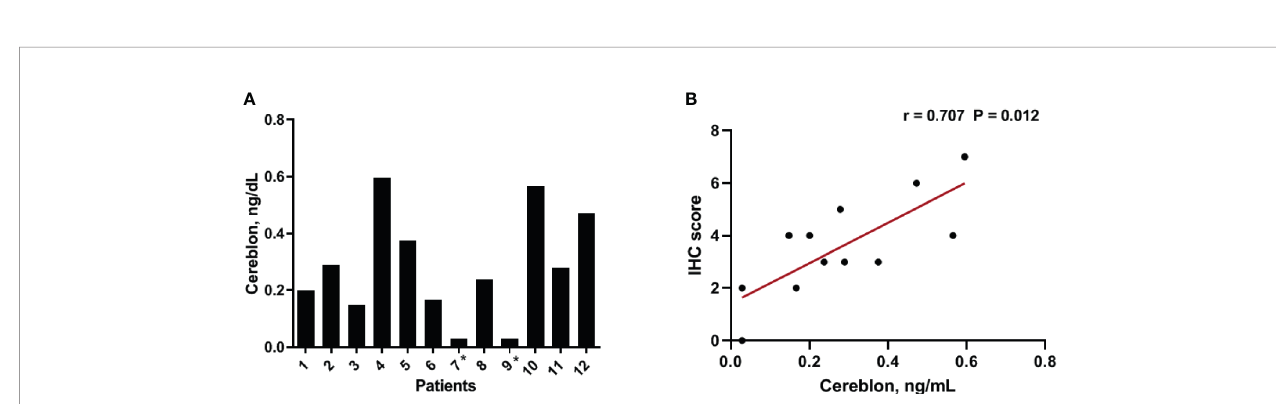
FIGURE 3 | Expression level of CRBN protein. The expression levels were analyzed using ELISA (A) The distribution of the CRBN protein levels from 12 patients. (B) Correlation between the CRBN expression level measured using ELISA and that obtained based on the H-score. *These values were below a detection limit range and replaced by half of the limit of detection values for statistical analysis.